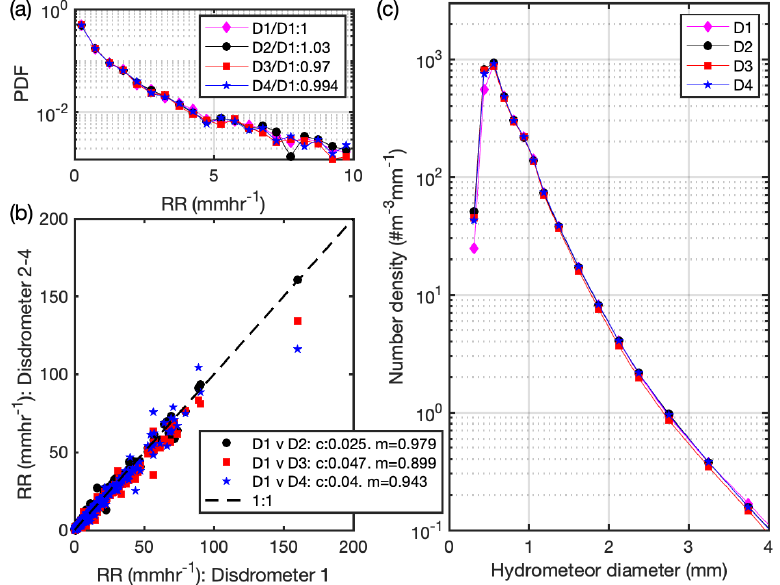
Figure 18. ( a ) Probability distribution and ( b ) Scatterplots of 1 min rainfall rates (RR, in mmhr − 1 ) from the four OTT Parsivel 2 disdrometers (D1, D2, D3, D4) operating at Cornell University during the second closure experiment, after disdrometer D3 had been repaired/recalibrated. The probability distribution of RR shown in panel ( a ) is discretized into 0.5 mmhr − 1 intervals and the legend reports the mean ratio of RR from the disdrometers. The legend in ( b ) denotes best-fit lines to the datasets where c is the intercept and m is the slope of a linear fit. ( c ) Mean DSD from the four instruments for all 6829 1 min periods when RR > 0 mmhr – 1 .